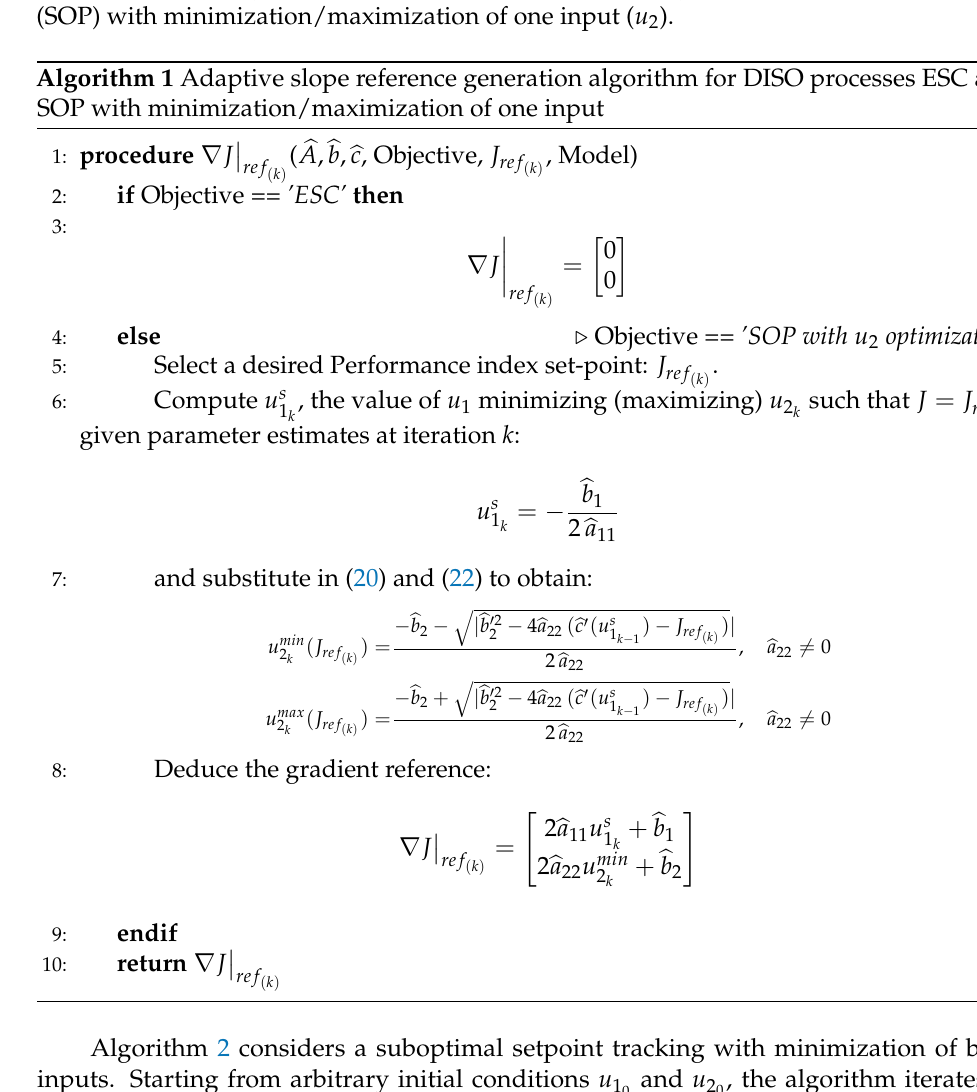
and u 2 , the algorithm iterates to 0 0 and u min based on the previous estimates u min and u min 2 k 2 k − 1 1 k 1 k − 1